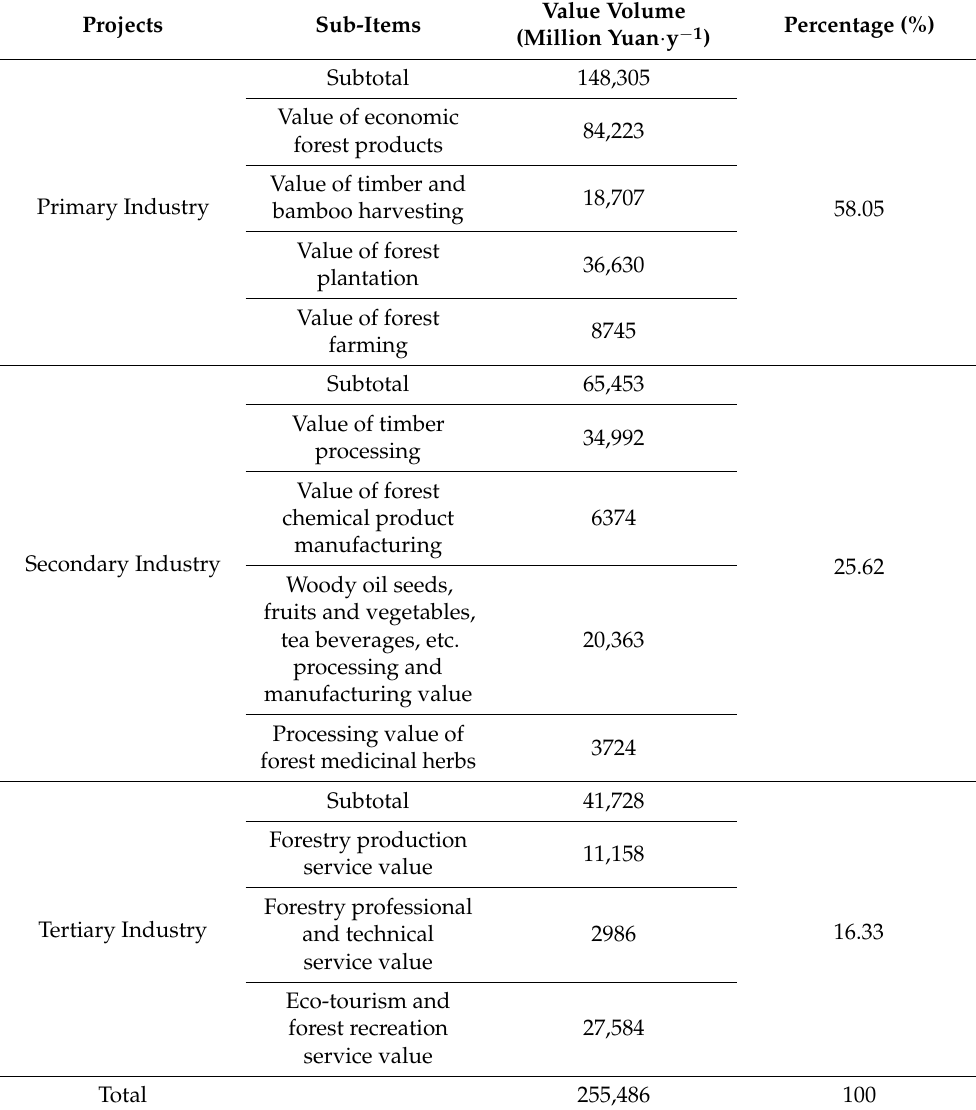
Table 5. Economic value of the CFFG project in